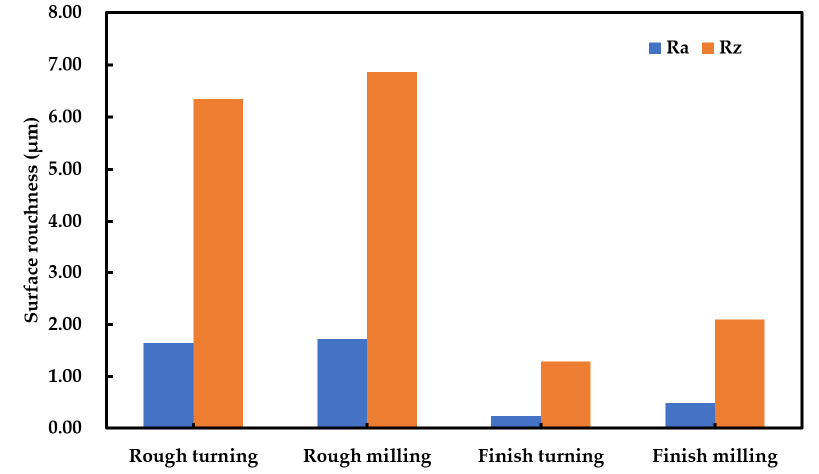
Figure 12. Surface roughness of the workpiece in rough and finish machining.